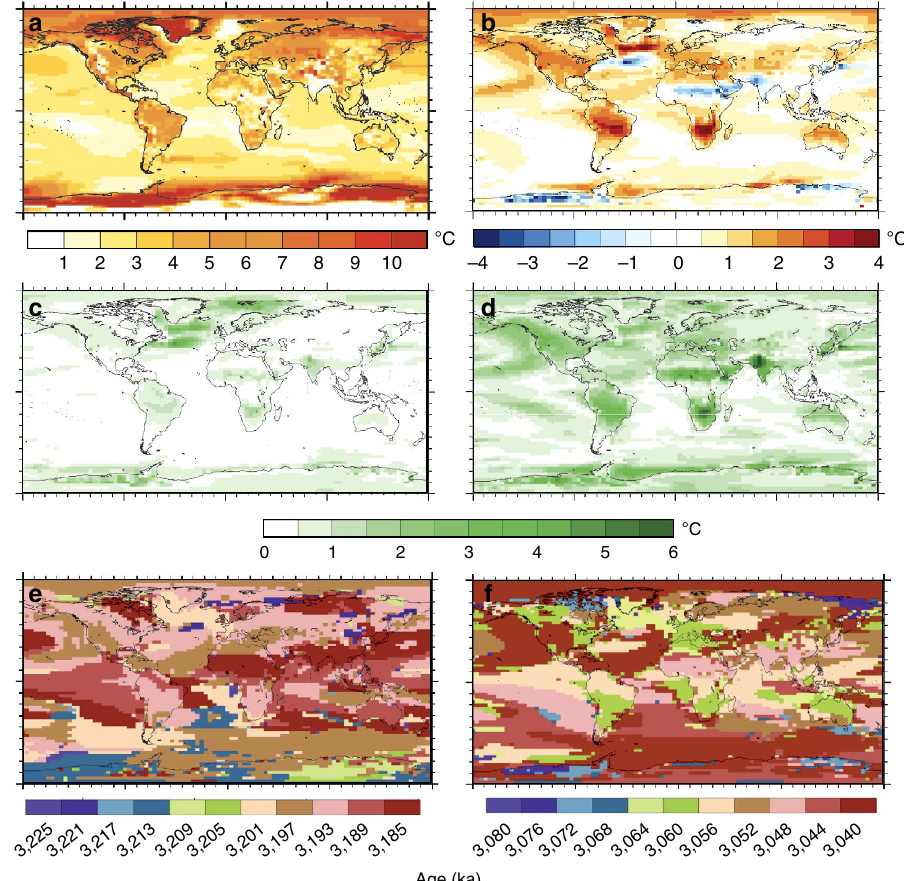
Figure 6 | Simulating Pliocene climate variability. Hadley Coupled Climate Model Version 3 (HadCM3) simulations of surface air temperature (SAT (cid:2) C) variability during the Pliocene redrawn and modified from ref. 107. ( a ) Annual mean Pliocene SAT ( (cid:2) C) prediction for interglacial Marine Isotope Stage (MIS) KM5c minus a pre-industrial experiment. ( b ) Annual mean SAT for Interglacial MIS K1 minus KM5c. Note that MIS K1 shows warmer SATs in most regions of the world compared to KM5c. ( c ) Variability in SATs 20 Kyrs ± of the benthic oxygen isotope peak of the KM5c interglacial. ( d ) Same as c but showing SATvariability ± 20 Kyrs around the benthic oxygen isotope peak of the K1 interglacial. Note the larger degree of SATvariability in d compared to c . ( e ) Timing of the maximum SATwarming relative to the pre-industrial in each model grid box for KM5c ± 20 Kyrs. ( f ) Same as e but for K1 ± 20 Kyrs. e and f Maximum SAT warming relative to the pre-industrial is not globally synchronous and varies in nature between MIS KM5c and K1. Modified from ref.